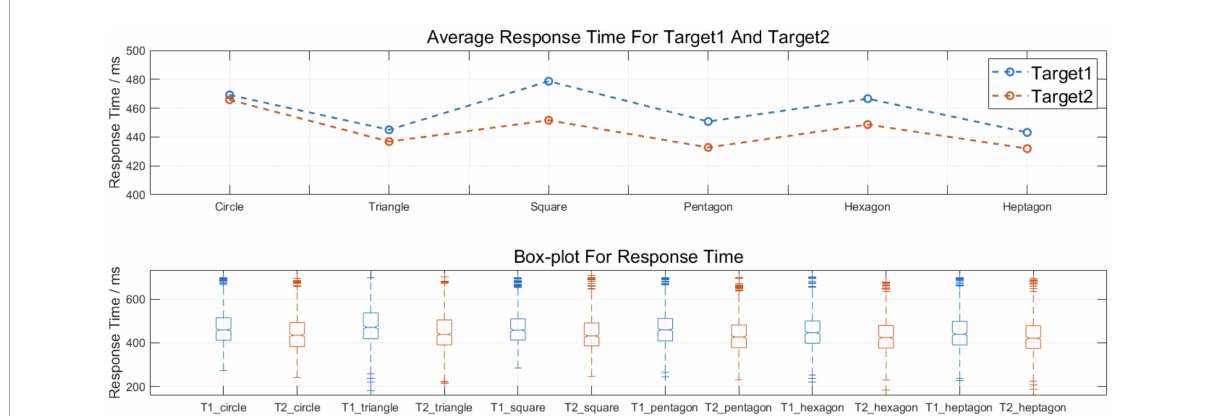
FIGURE4 The behavioral results between blocks and within blocks. The mean response time (RT) for Target 2 was significantly shorter than the mean RT for Target 1, t (5079) = 13.75, ∗∗∗ p < 0.001, Cohen’s d =